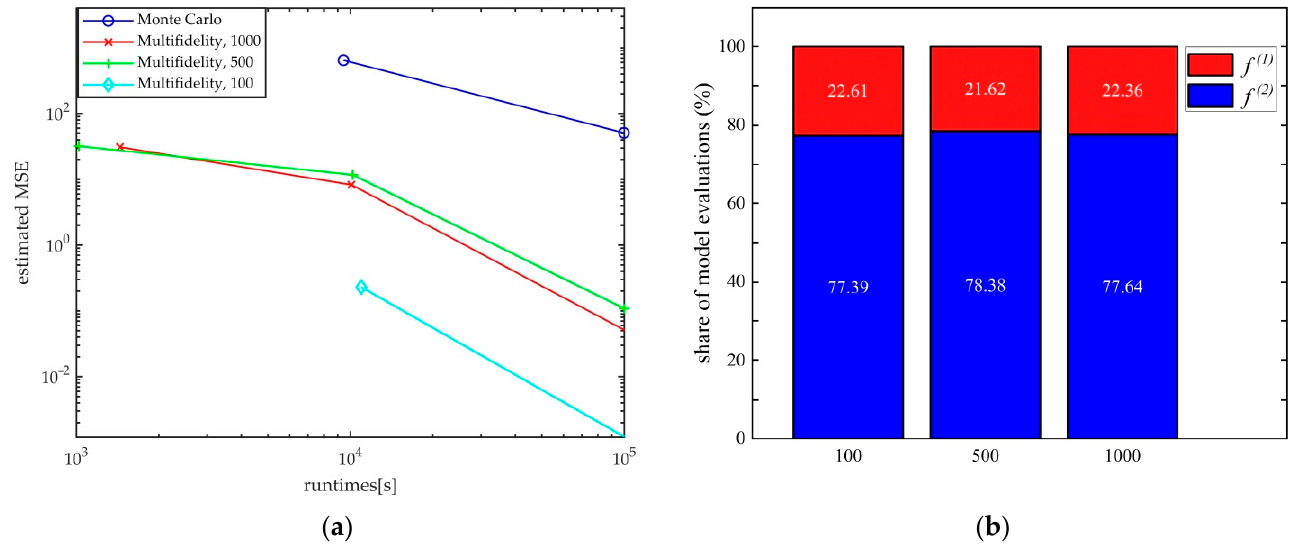
Figure 3. ( a ) Comparison the estimated MSE of our MFMC estimators from 100, 500 and 1000 samples, respectively; ( b ) Proportion plot of the number of model calculations m for MFMC estimator when the sample numbers are 100, 500 and 1000. Table 3. Comparison of correlation coefficient using 100, 500 and 1000 samples, respectively.